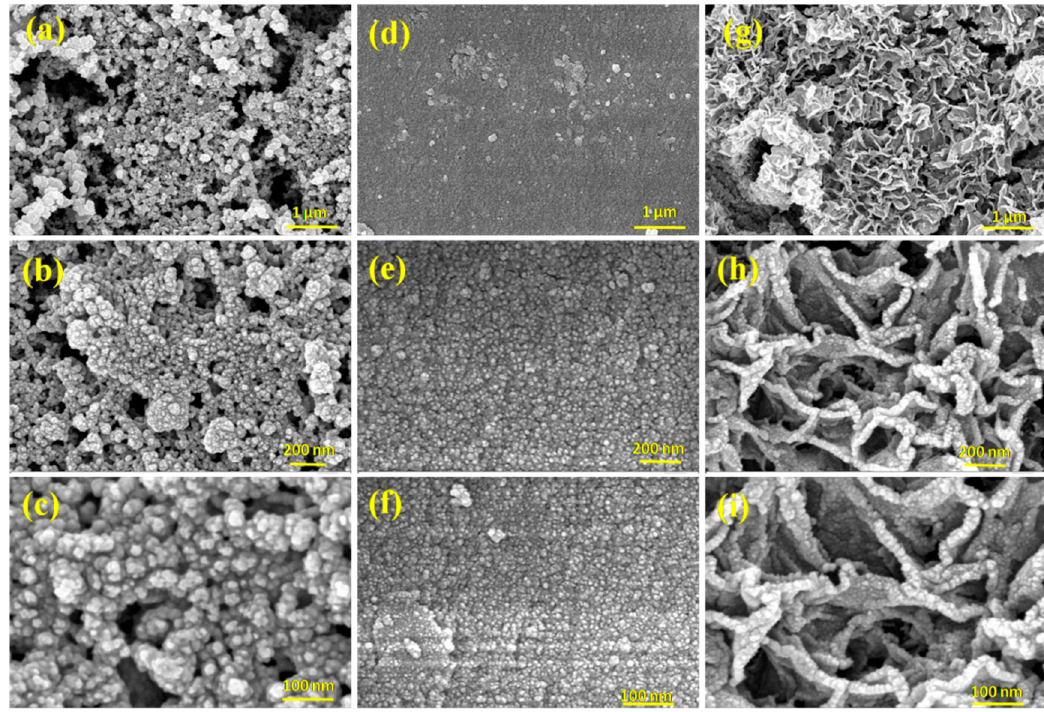
Figure 2. FE-SEM images of nY 2 O 3 at ( a ) 1µm, ( b ) 200 nm, and ( c ) 100 nm; APTES/nY 2 O 3 /ITO at ( d ) 1µm, ( e ) 200 nm, and ( f ) 100 nm; and anti-CYFRA-21-1/APTES/nY 2 O 3 /ITO at ( g ) 1µm, ( h ) 200 nm, and ( i ) 100 nm.